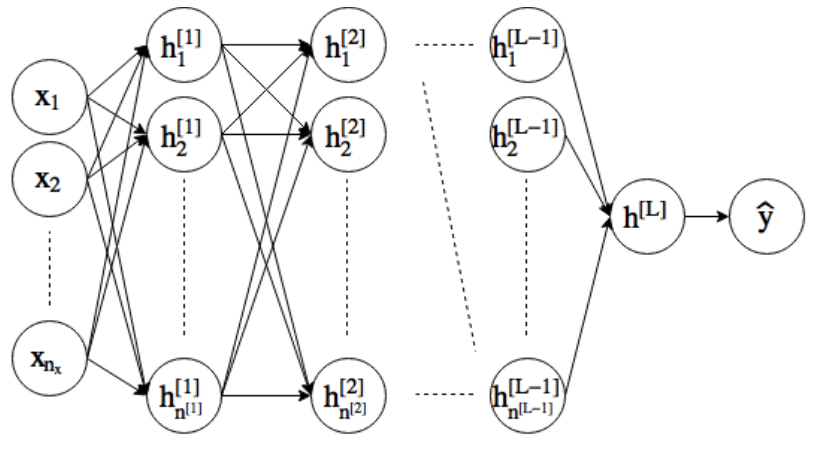
Figure 1. Feedforward neural